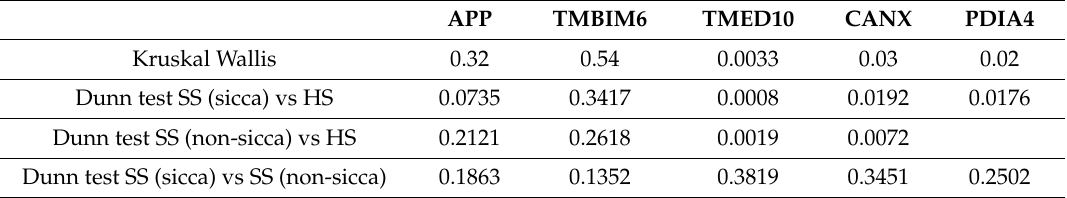
Table 5. APP, TMBIM6, TMED, CANX, and PDIA4 relative gene expression in healthy control subjects (HS), SS patients with xerostomia SS (sicca) and SS patients without xerostomia SS (non-sicca).